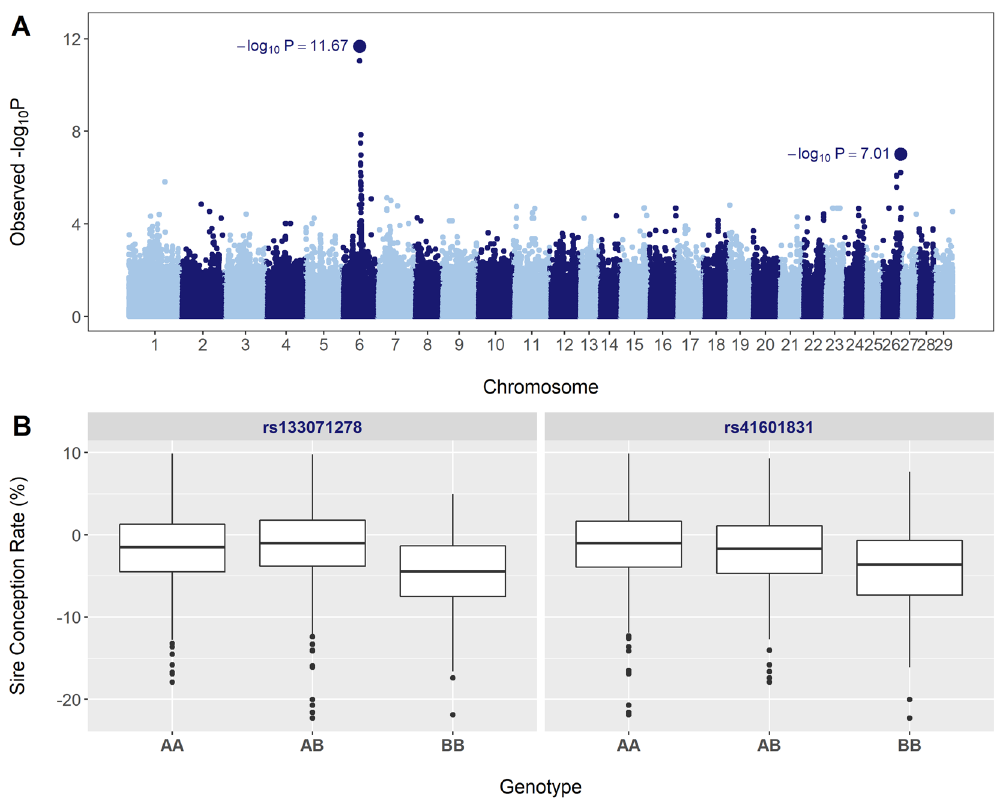
Figure 2. The relevance of non-additive effects on male fertility in Brown Swiss cattle. ( A ) Manhattan plot showing the significance of recessive effects. ( B ) Box plot showing the distribution of sire conception rate values for the two SNP loci with marked recessive